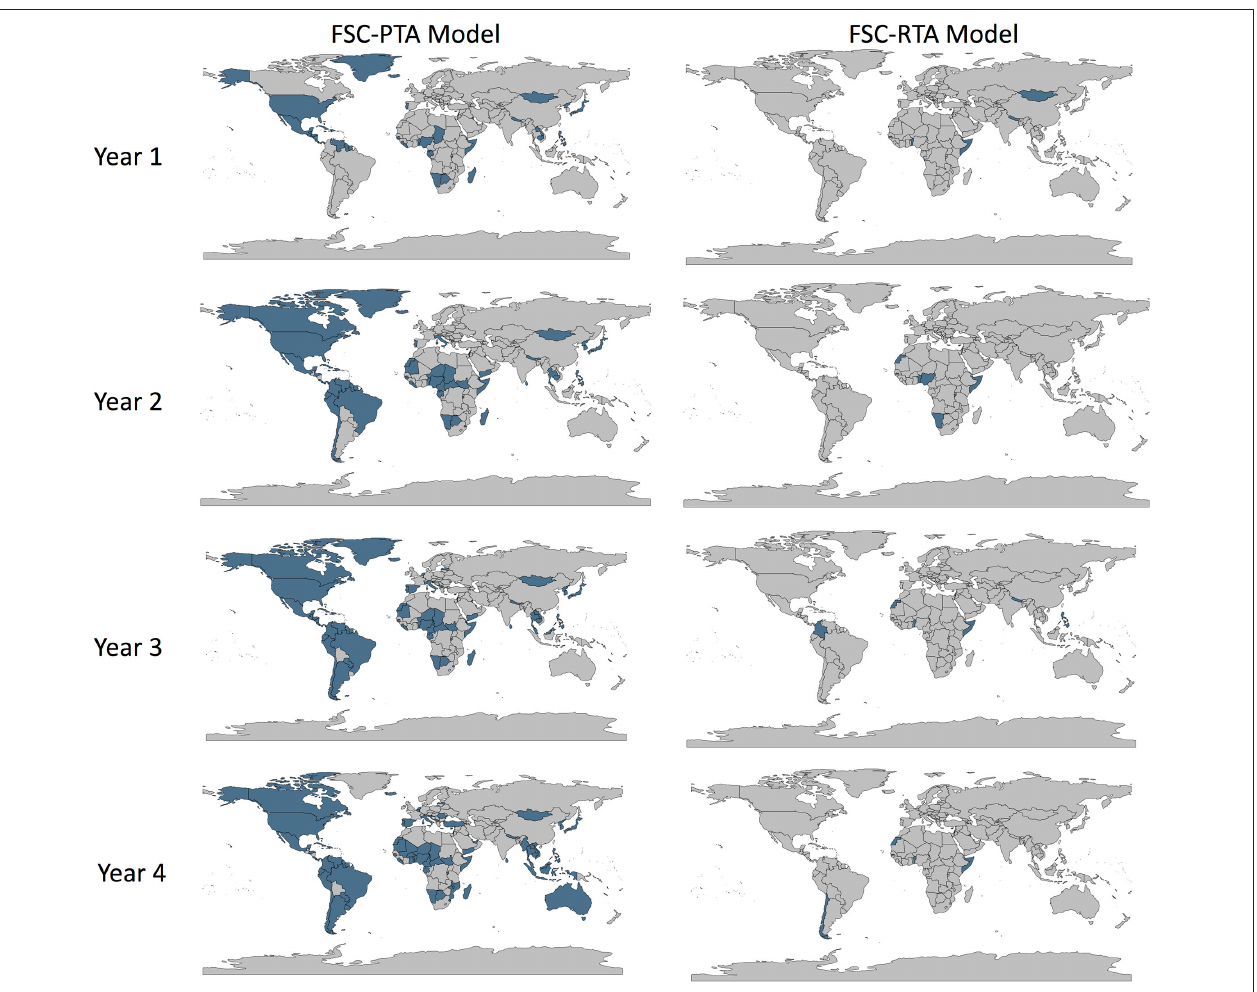
FIGURE 4 | Countries with consumption declines from shock to US wheat production using the FSC-PTA and FSC-RTA models.